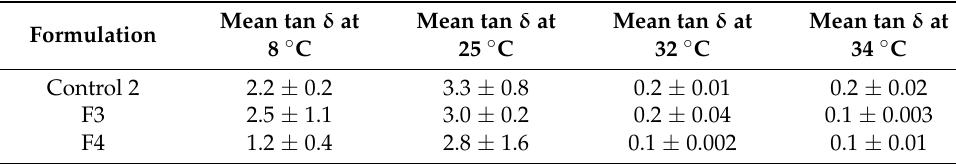
Table 6. Mean tan δ of Control 2, F3 and F4 at different